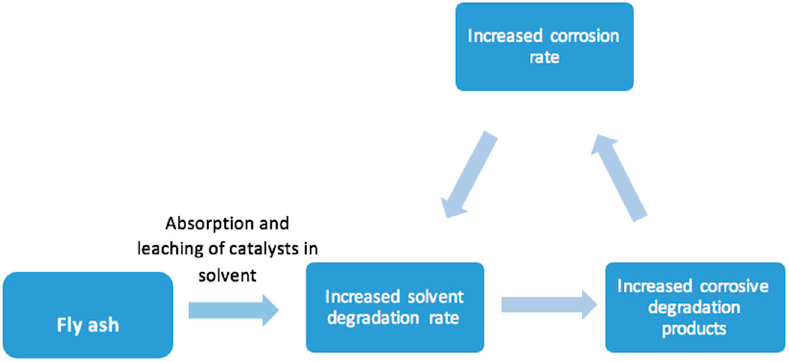
Figure 3. Scheme of auto-catalytic oxidative degradation mechanism occurring in a PCCC unit.